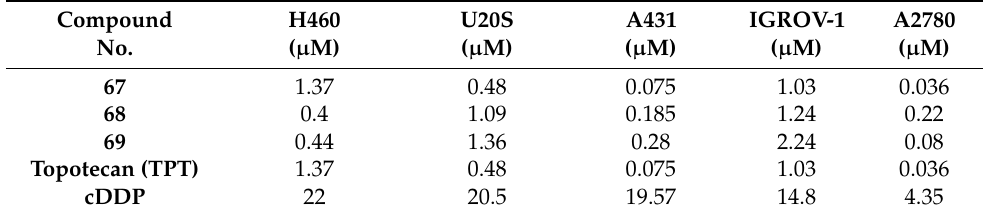
Table 53. In vitro cytotoxic activities of camptothecin-linked platinum hybrid compounds ( 67 – 69 ). Compound